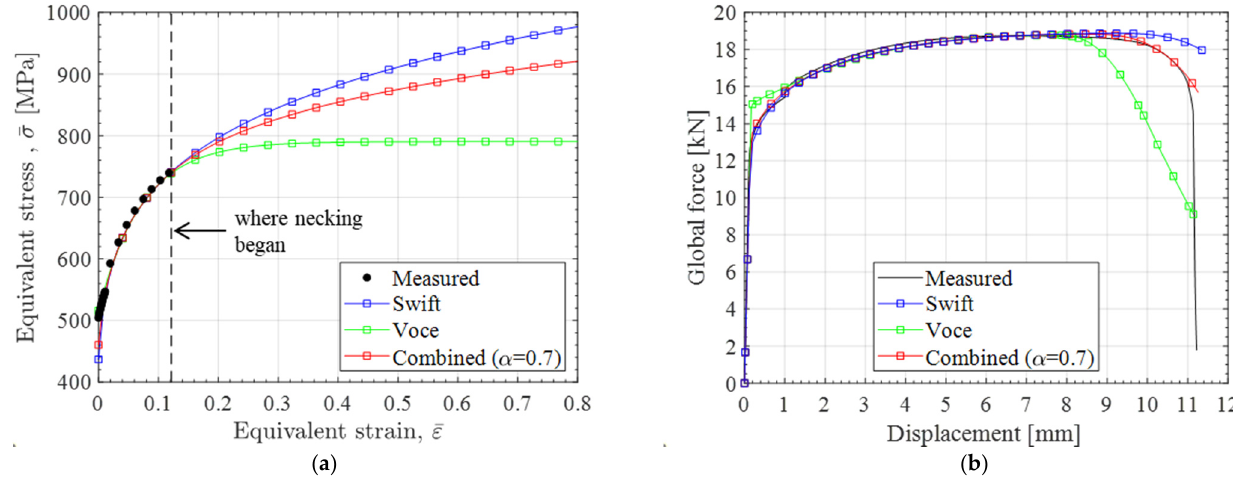
Figure 5. ( a ) Equivalent stress–strain curves of 3.0 wt% silicon steel used for the FE analysis; ( b ) Global force–displacement response of 3.0 wt% silicon steel when Swift, Voce, and combined models were used.